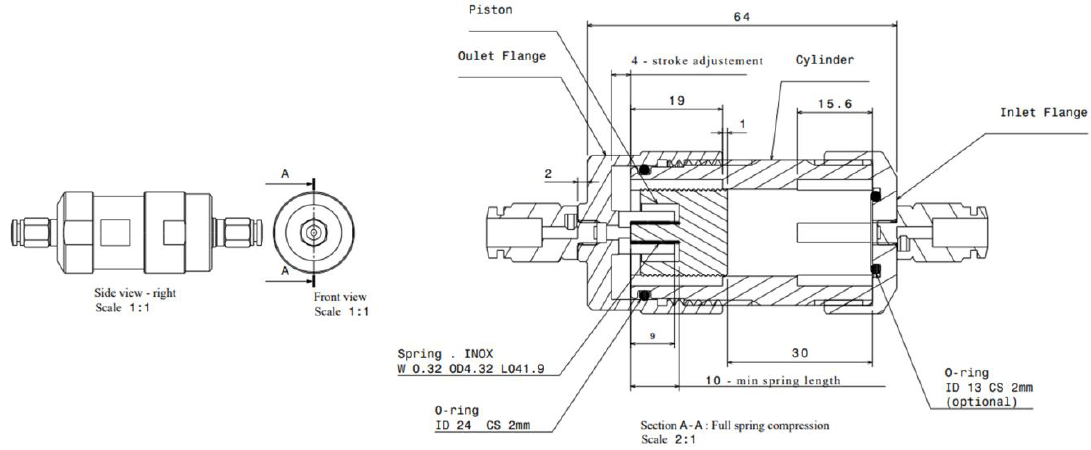
Figure 6. Side and front views of the device. The nominal dimensions are indicated in Section A-A.